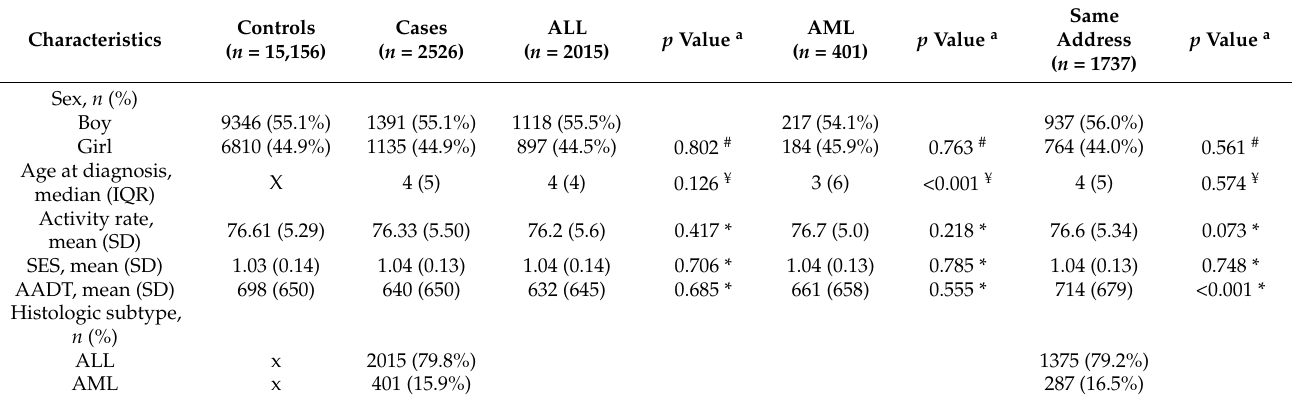
Table 1. Childhood leukaemia—cases and sensitivity group and controls’